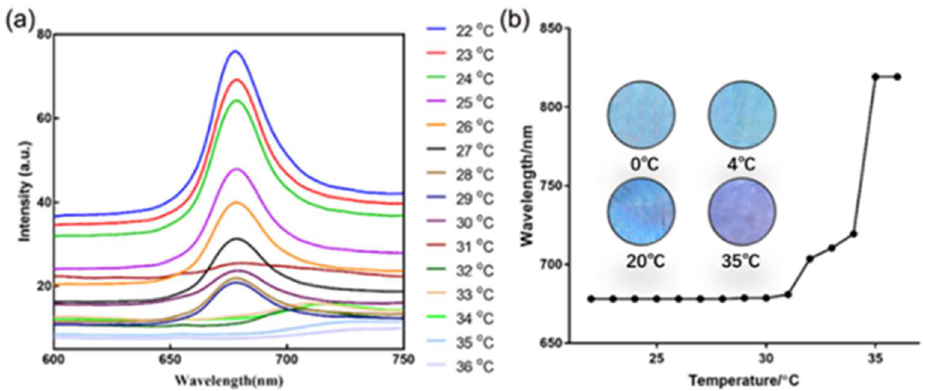
Figure 5. ( a ) The reflection spectrum of the SF-PNIPAM dual-crosslinked nanocomposite films with the change of temperature; ( b ) The relationship between reflection peak wavelength and temperature (Illustration: Structural color of the SF-PNIPAM dual-crosslinked nanocomposite film at a different temperature).